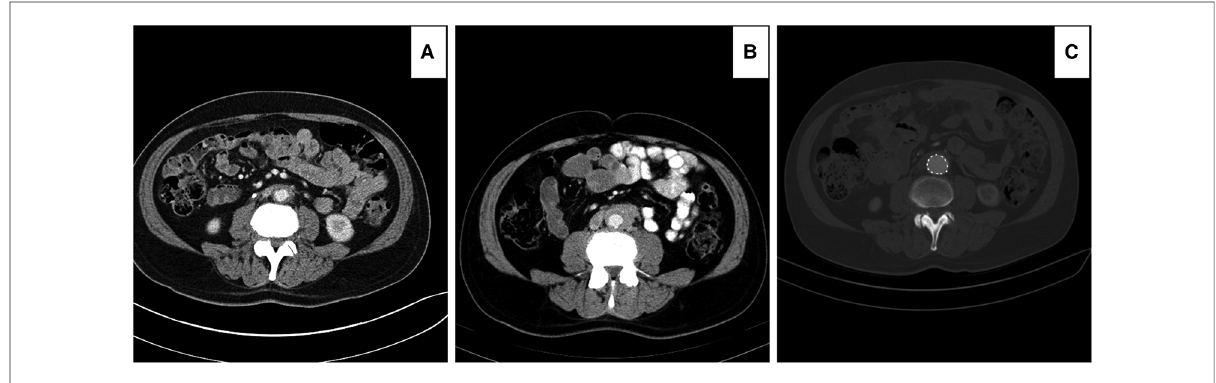
FIGURE 9 Computed tomography angiography (CTA) images showing improvement in peri-aortic soft tissue enhancement following endovascular aneurysm repair (EVAR): ( A ) peri-aortic enhancement of 3 mm on optimal medical therapy for three months. ( B ) Peri-aortic enhancements increased to 6 mm after optimal medical management for nine months. ( C ) peri-aortic enhancements disappeared with no evidence of RPF six months